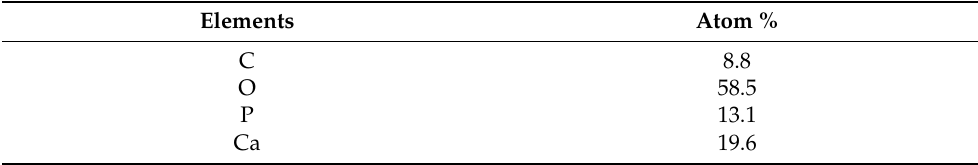
Figure 4. EDX spectrum of a sample, taken with an FEI Quanta ESEM FEG 250 FEG and an Oxford EDX unit, 10 kV acceleration voltage, 30 min counting period live time corrected. Table 5. Proportions of relevant elements in the EDX